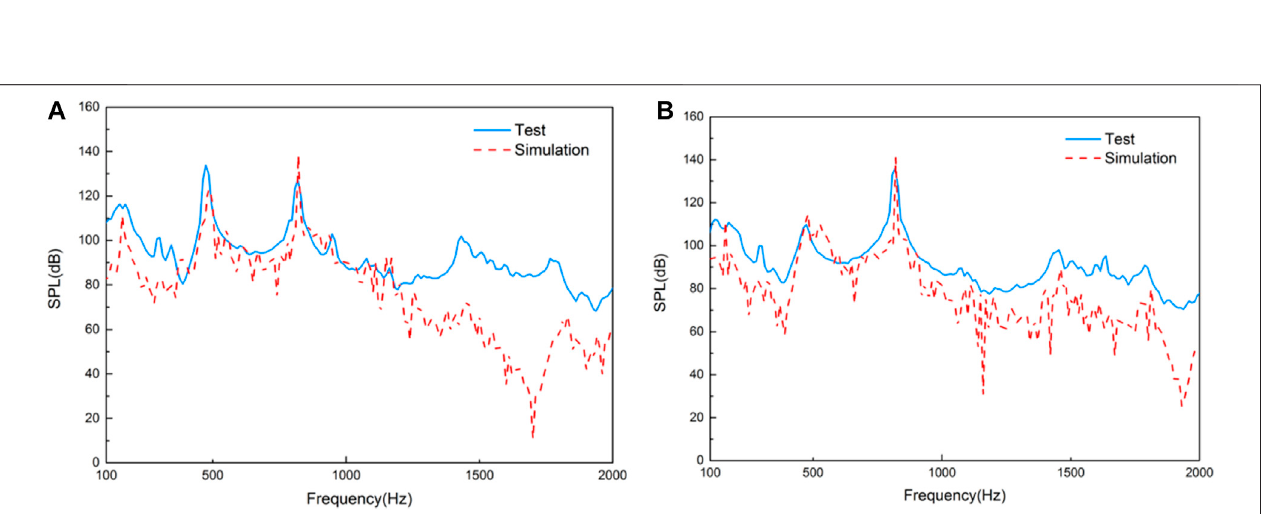
FIGURE 10 | The SPL spectrum comparative curves of different points: (A) P3 SPL curves; (B) P5 SPL curves.